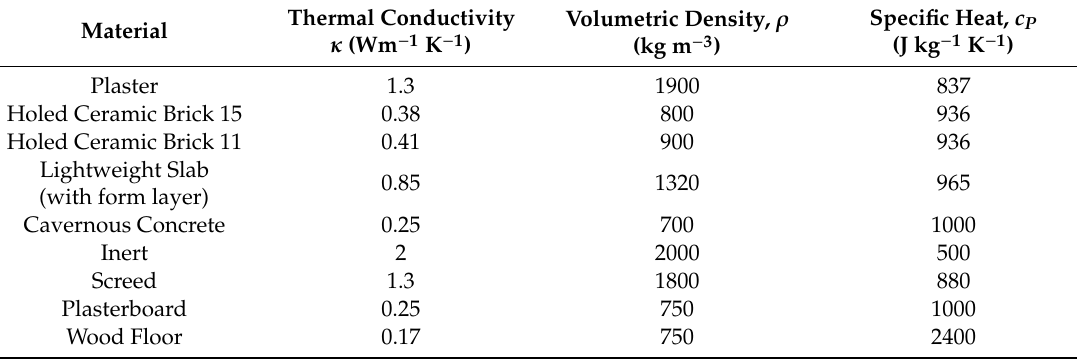
Table 4. Materials properties considered in the room